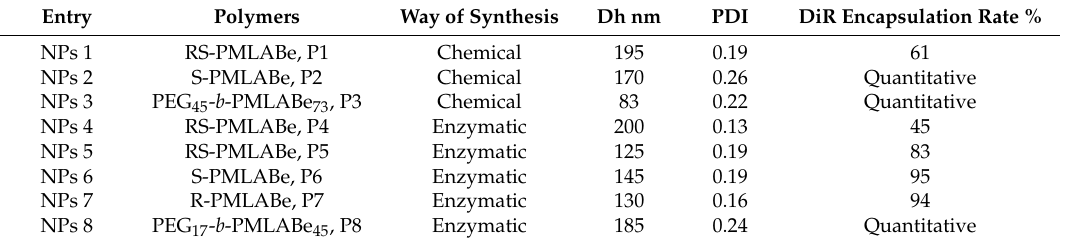
Table 4. Characteristics of the prepared NPs loaded with DiR formulated for the cell uptake studies. Entry